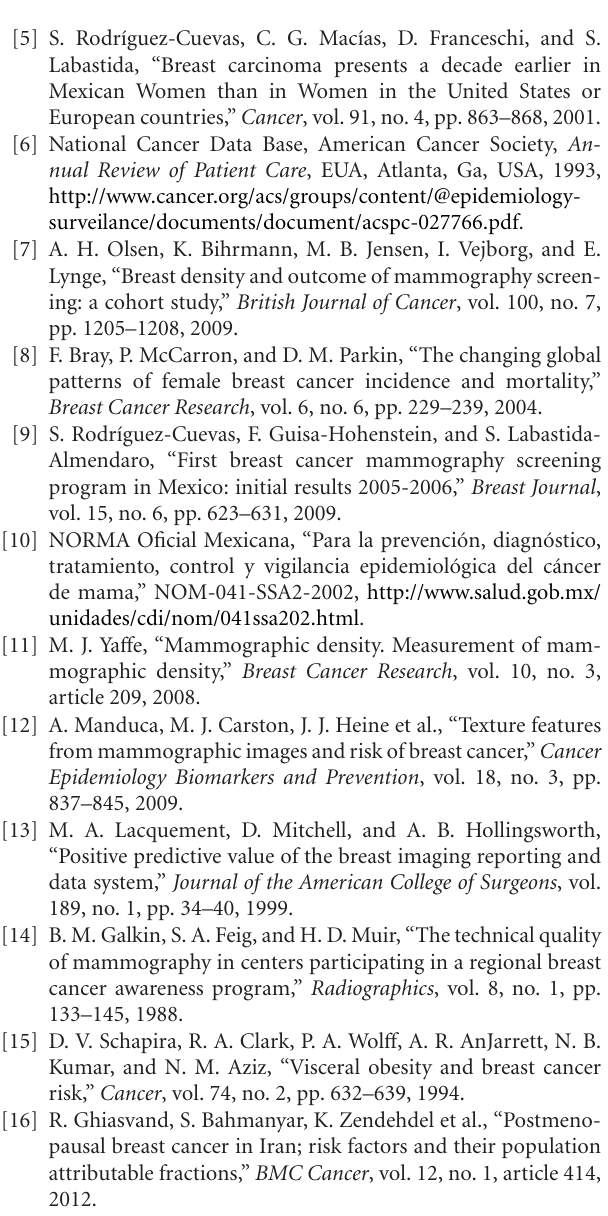
Table 5: Distribution of mammographic diagnostics (BI-RADS) according to breast densities patterns. BI-RADS BI-RADS